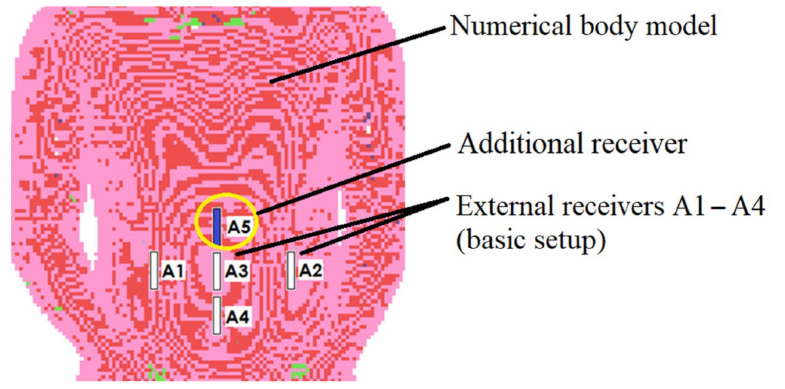
Figure 3. Arrangement of the receiving antennas A1–A5 relative to the numerical model used in simulation.